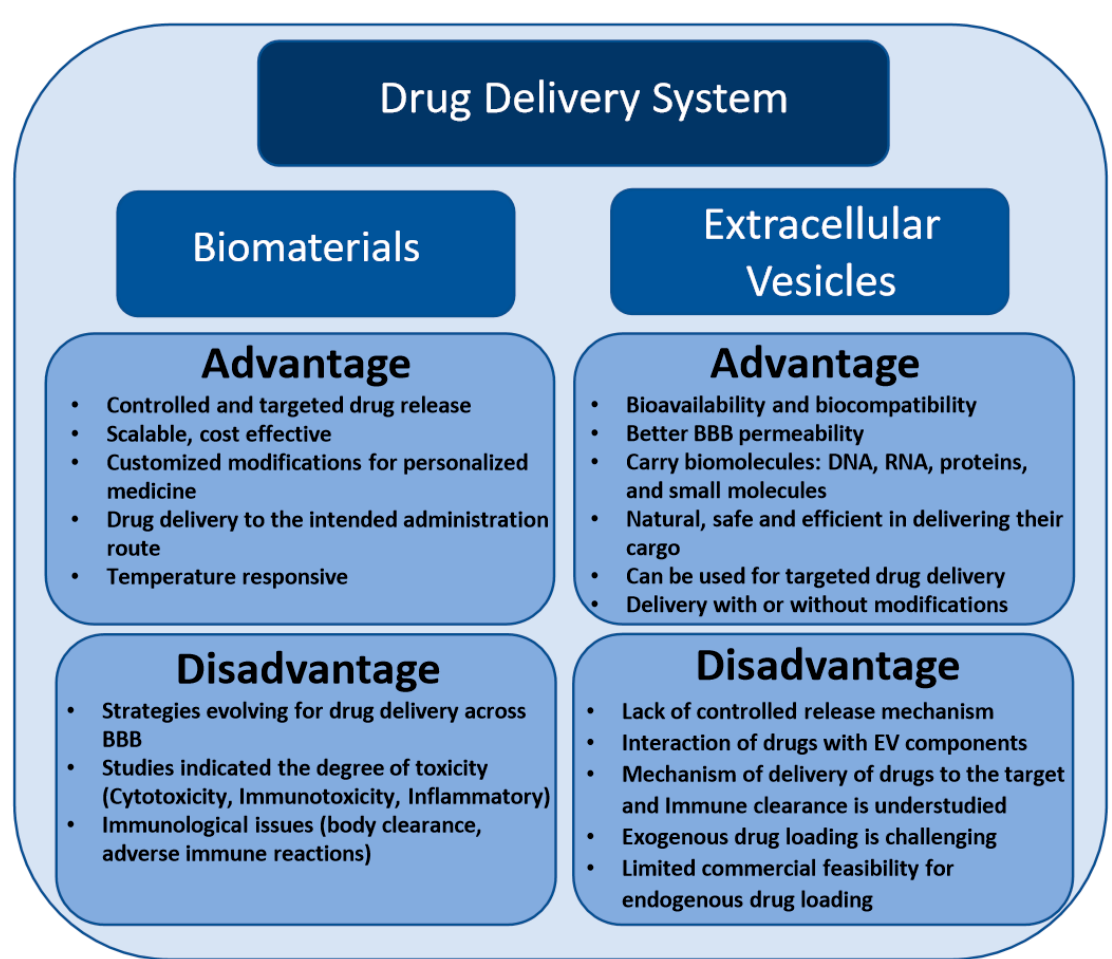
Figure 1. Possible advantages and disadvantages of biomaterials and extracellular vesicles as a drug delivery system. Funding: This study is partially supported by funding from the National Institute of Health